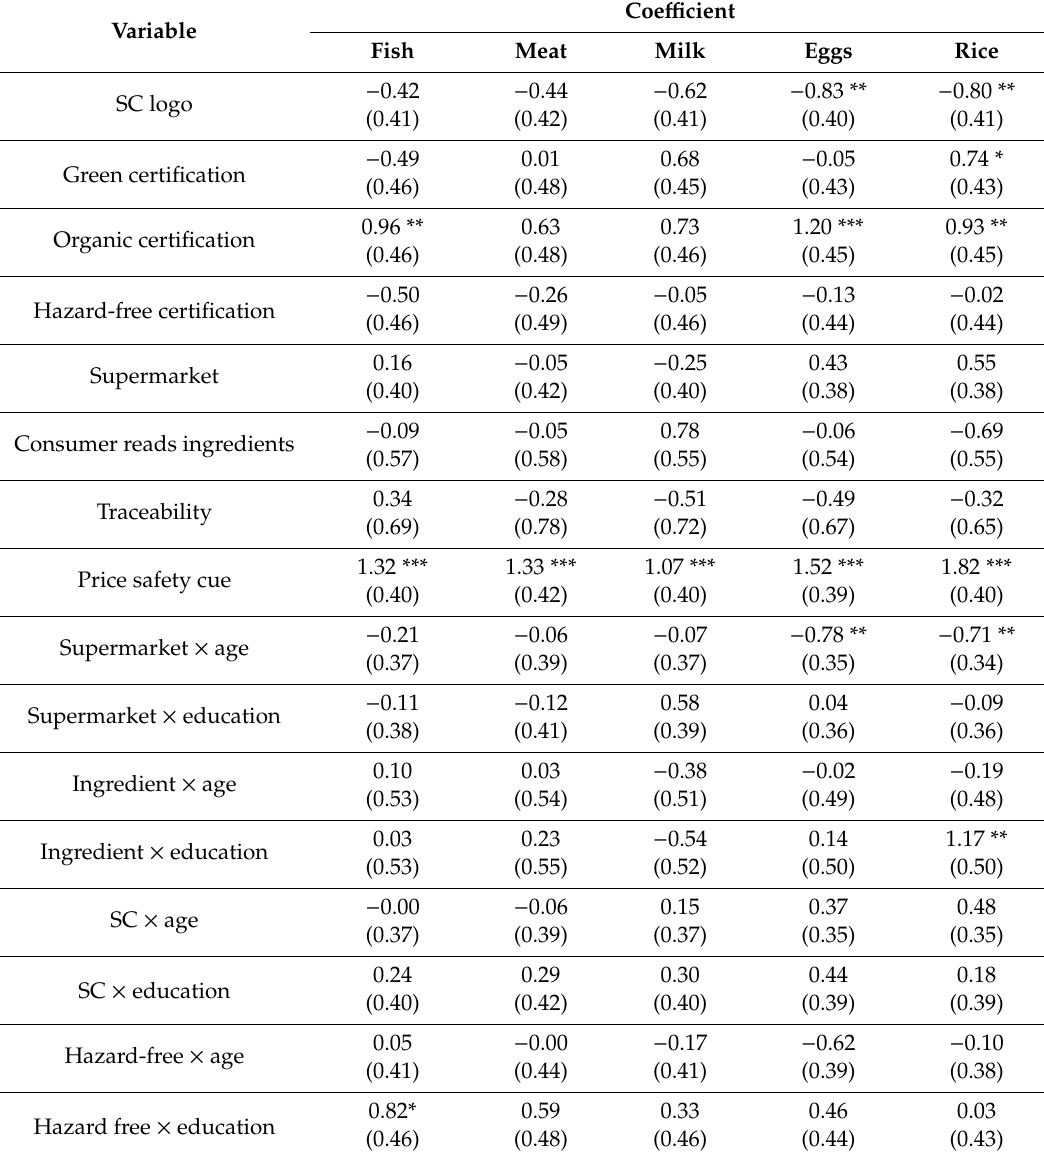
Table 4. Influence of certifications with age and